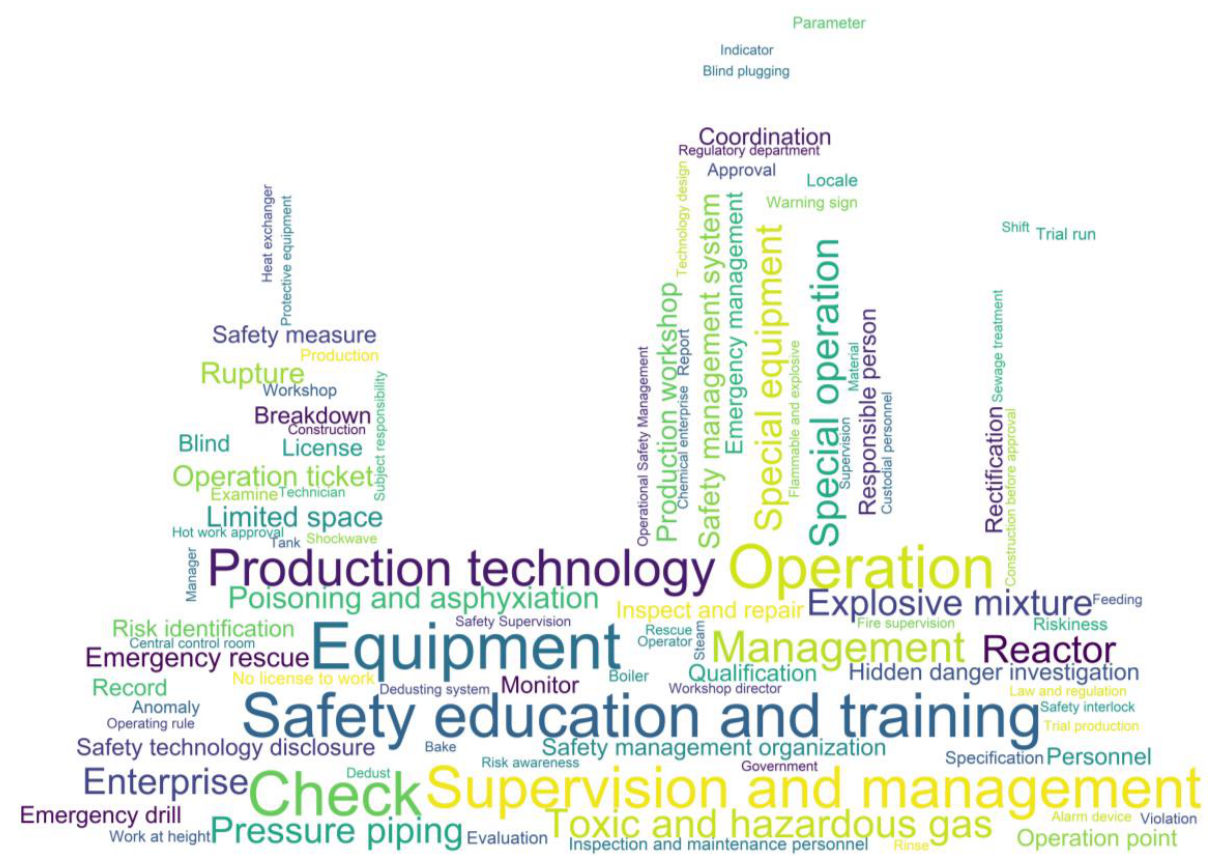
Figure 7. Word cloud visualization of the top 100 keywords. Word cloud analysis provides a quick and visual representation of key information.